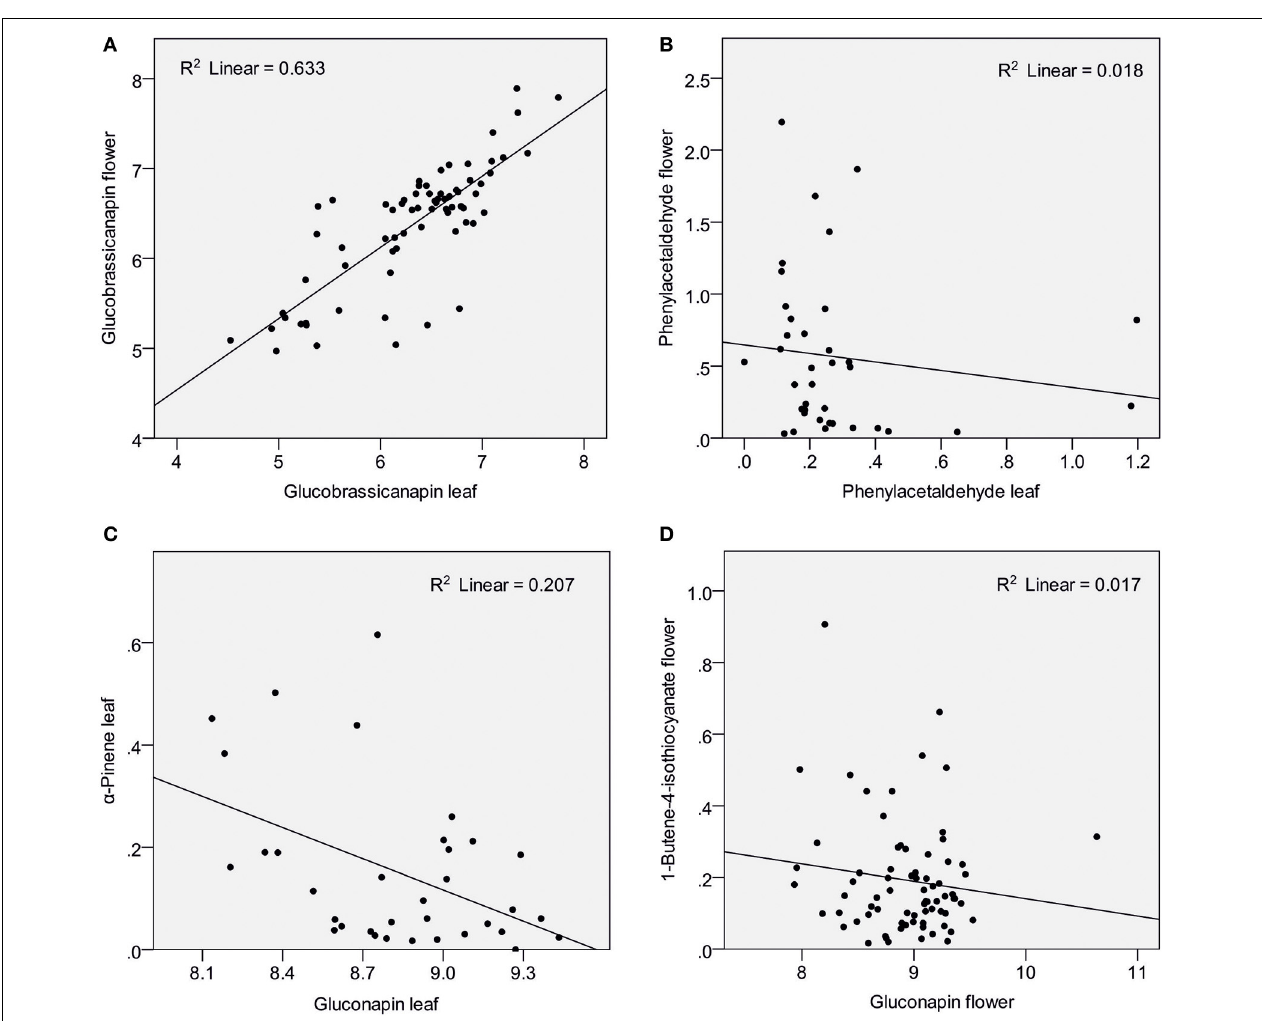
FIGURE 1 | Scatter plots showing amounts of glucosinolates and VOCs (ln transformed values) in Brassica rapa . The figure shows examples of strong correlation between leaf and flower glucosinolates (A) , lack of